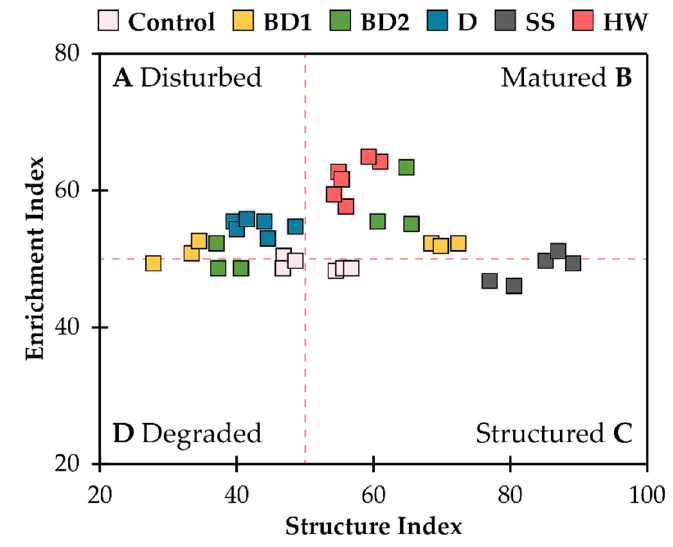
Figure 2. Nematode faunal analysis indicating the food web status (A–D) in different amendments type: BD1, BD2, D, SS, and HW.